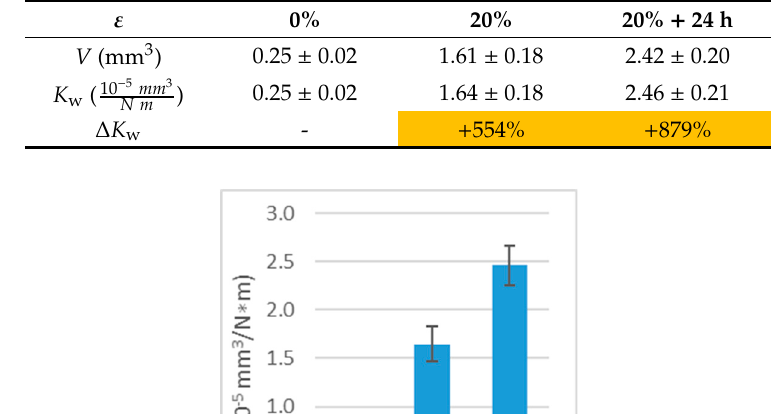
Table 4. Results of microhardness tests for polymers deformed by tension. Direction of indenter